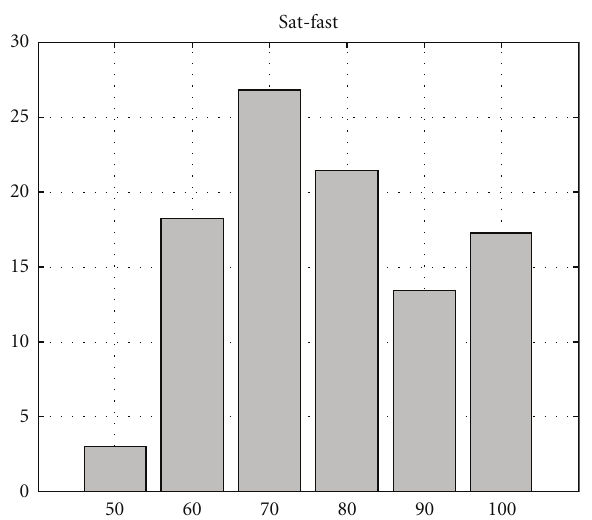
Figure 9: Satisfaction histogram for Fast-MKP Algorithm with priority-oriented scaling scheme.